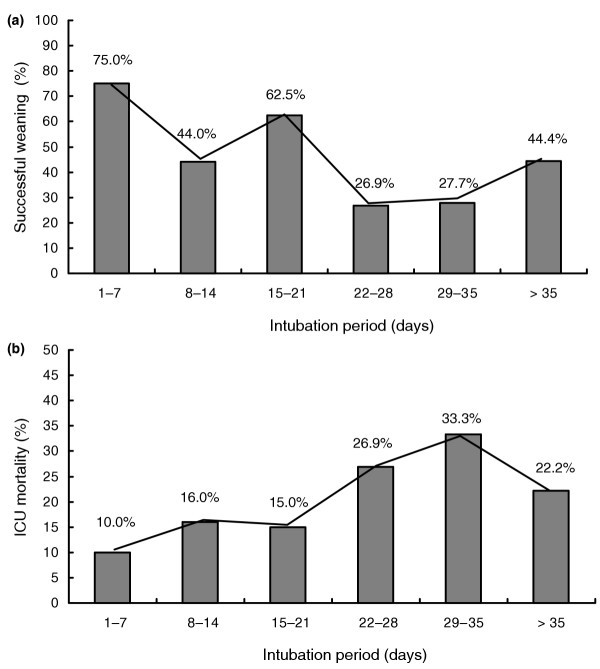
The relationship of weaning rates, ICU mortality and durations of intubation. (a) Rate of successful weaning in patients who underwent tracheostomy after different durations of intubation. The rate of successful weaning declined when patients underwent tracheostomy after 21 days of intubation. (b) Intensive care unit (ICU) mortality rates in patients who underwent tracheostomy after different durations of intubation. The ICU mortality rates increased when the patients underwent tracheostomy after 21 days of intubation.